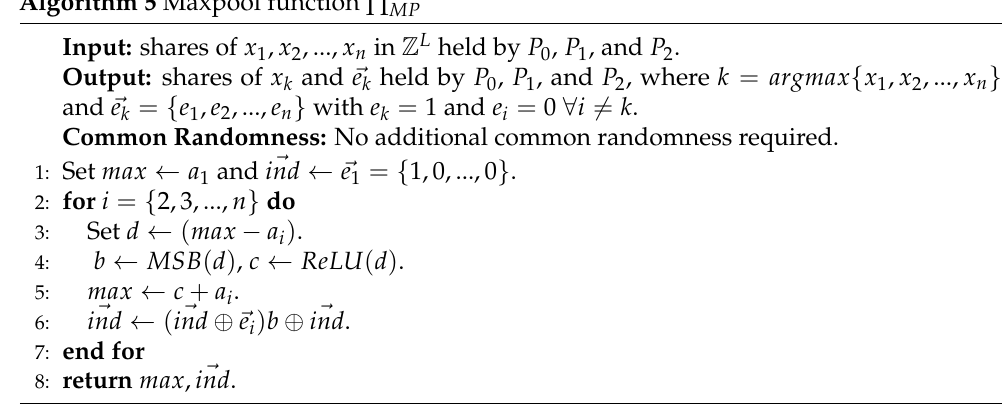
Algorithm 5 Maxpool function ∏